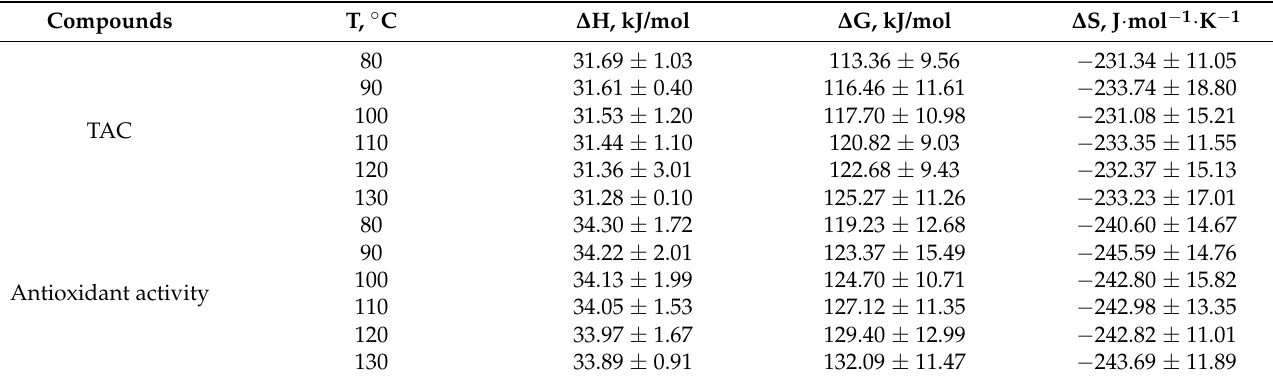
Table 5. Thermodynamic parameters obtained for phytochemical degradation in eggplant peel extract.